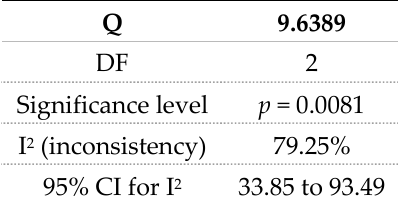
Figure 2. Forest plot showing pooled hazard ratios for the effect of ASA exposure on incident depression.